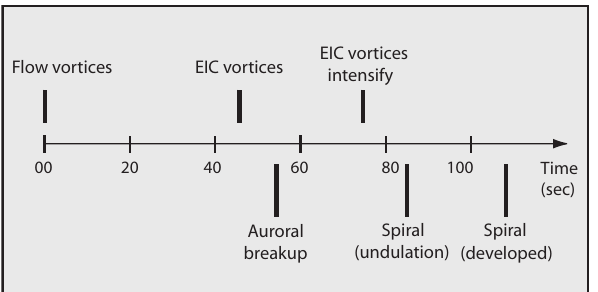
Fig. 10. Sequence of events for the first auroral spiral on 19 Febru- ary 2008. Times are displayed relative to the first sign of a flow vortex in space (i.e., at TH-C) and can be found in Table 1. See the text for further description.